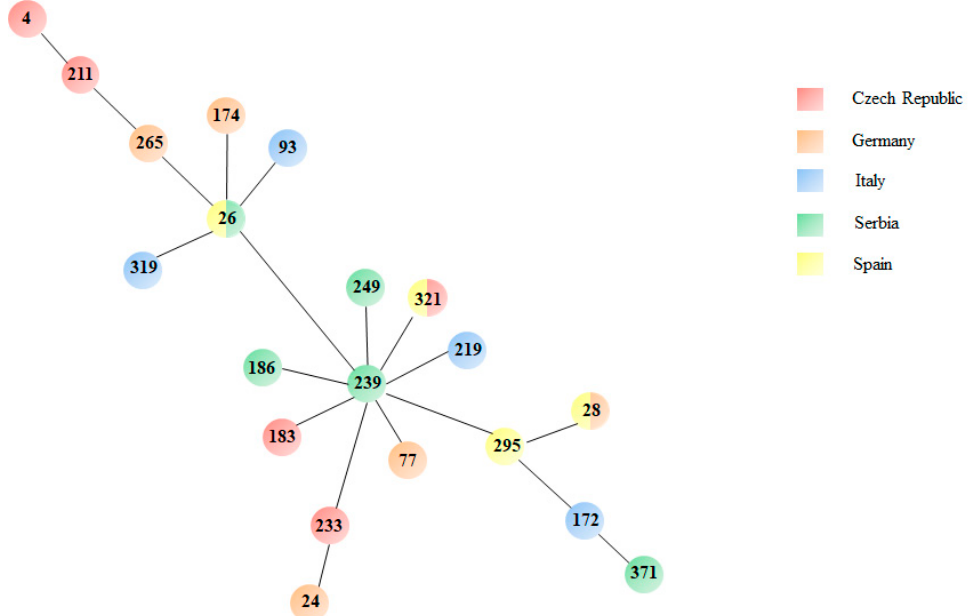
Figure 4. Comprehensive phylogenetic tree of S maltophilia strains selected for MLST analysis. Minimum spanning tree obtained using PHLOViZ Online software. The sequence types are shown in the circles, while isolation countries are indicated with different colors.